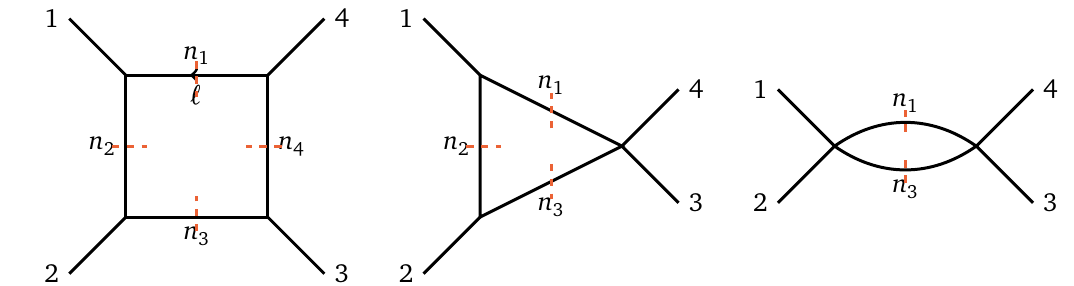
Figure 22: Field theory diagrams leading to Landau singularities in the string ampli- ∈ (cid:90) tude. The numbers n ⩾ 0 label the mass square of the corresponding particle in the i field theory. Only the normal thresholds (right) are present in physical regions, and only the normal and box anomalous thresholds (left) appear on the physical